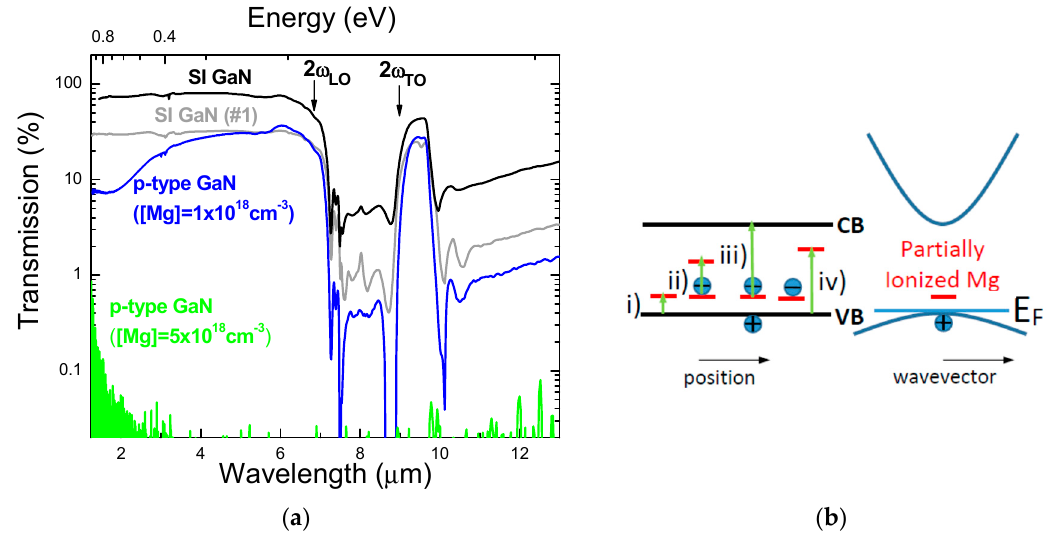
Figure 4. ( a ) Transmission spectra of p-type GaN of various hole concentrations (color lines) together with transmission spectra of SI GaN (black and grey lines) measured at room temperature in the near- and mid-infrared spectral region. ( b ) The sketch of light absorption in p-type GaN which is associated with dopants.